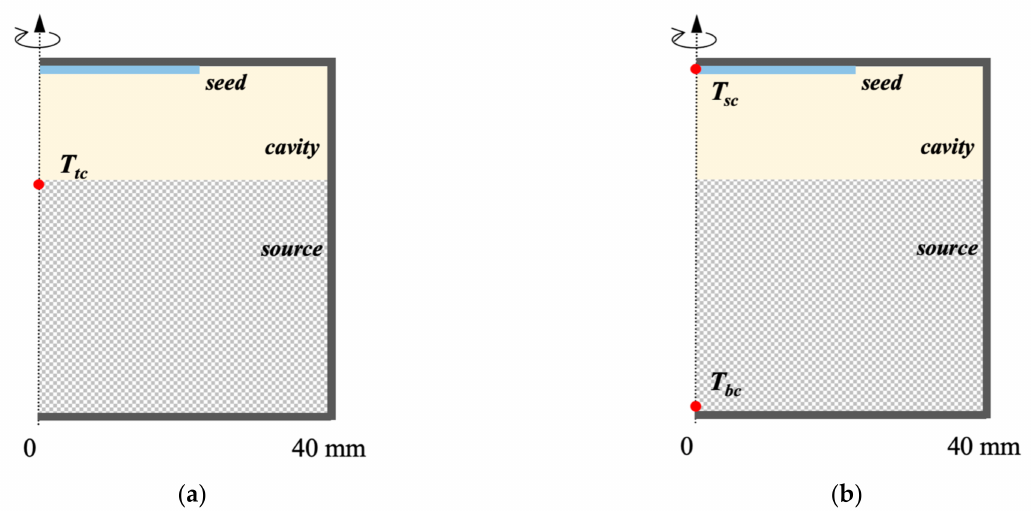
Figure 1. Schematic of AlN growth chamber. ( a ) Mode I: the top center of the powder source as TCP. ( b ) Mode II: the seed center and bottom center of the powder source as two TCPs.